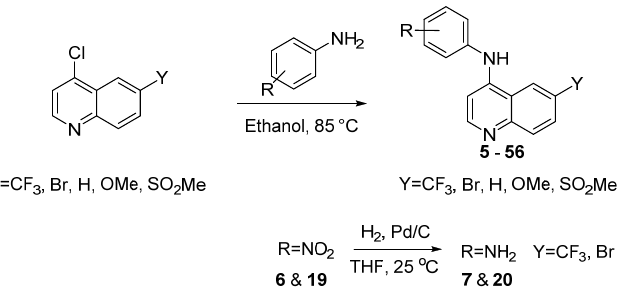
Table 1. Screening results of anti-DENV activity of initial SAR around 3-methoxy aniline substitu- tion pattern of